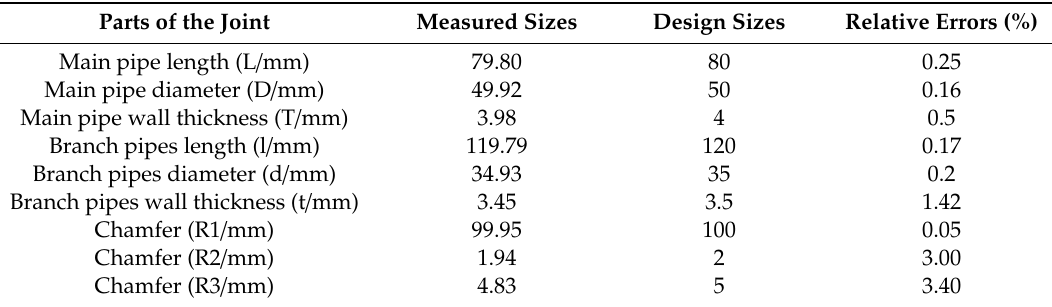
Table 5. Actual print size of the test